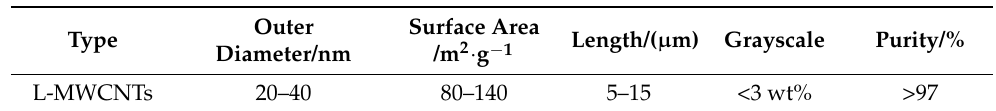
Table 3. Characteristics of